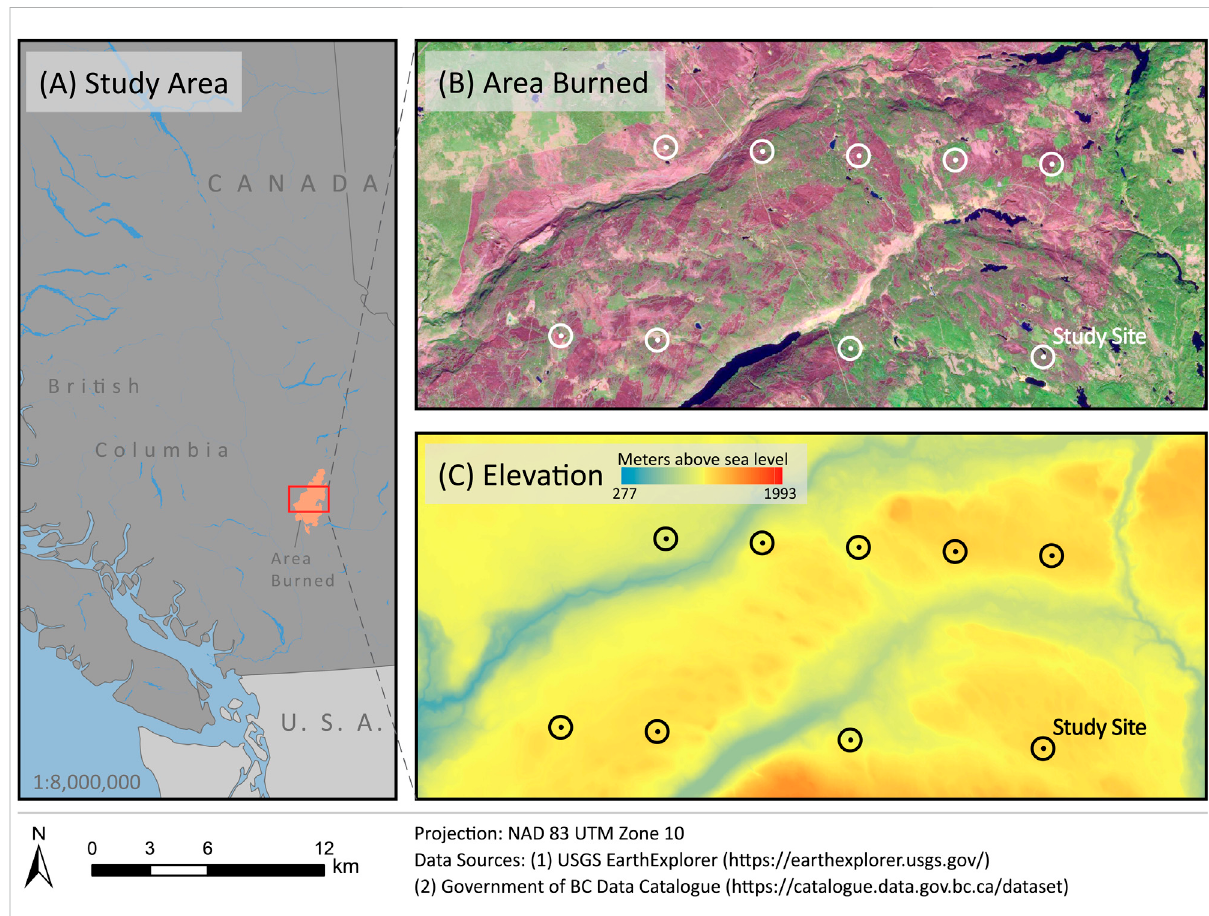
FIGURE 1 Thelocationofthestudyarea (A) intheElephantHillwild fi rethatburnedin2017.Thedistributionofthestudysiteswashighlightedusingcircles and dots in (B) and (C) . The area burned was visualized using a Sentinel-2 image (true color composite) with a 0.5 percent minimum-maximum clip and 1.3 gamma stretch to differentiate burned (magenta) and unburned (green) regions.